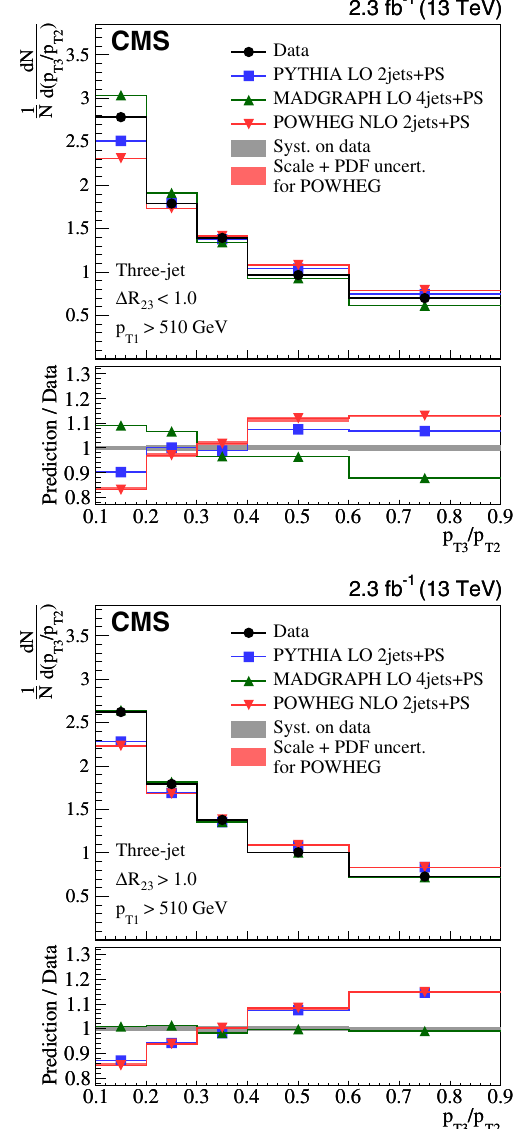
√ s = 13TeV compared to theory: (upper)